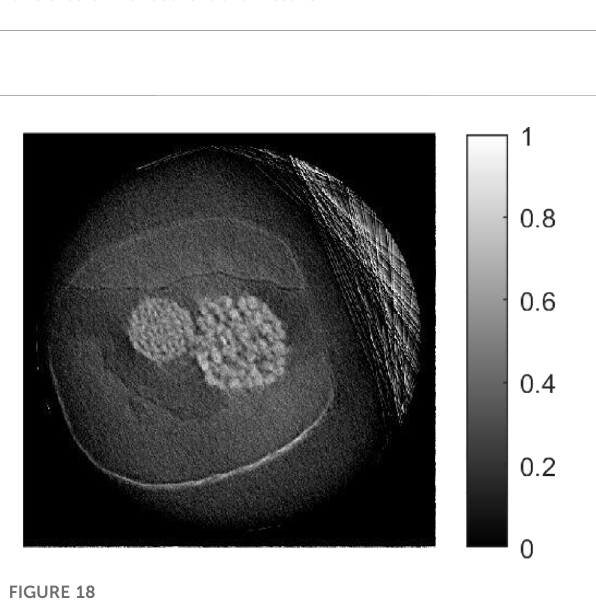
FIGURE 17 One slice of the reconstruction results: TFDM.